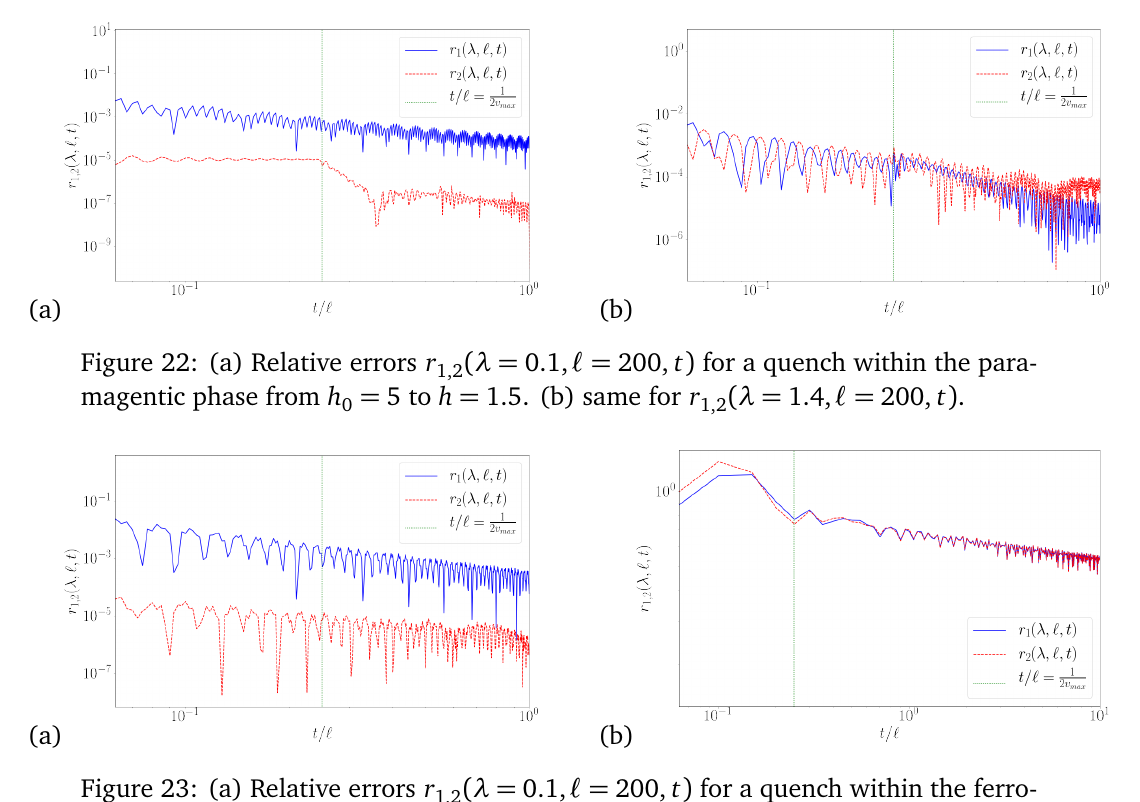
( λ = 1.4, (cid:96) = 200, t ) 1,2